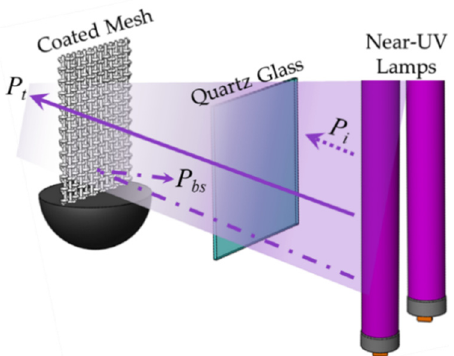
Figure 16. Schematic diagram of light photons irradiation, showing incident light (P i ), transmitted light (P t ) and backscattered light (P bs ), resulting from the interaction with the immobilized photo- catalyst on Photo-CREC-Air Reactor mesh.